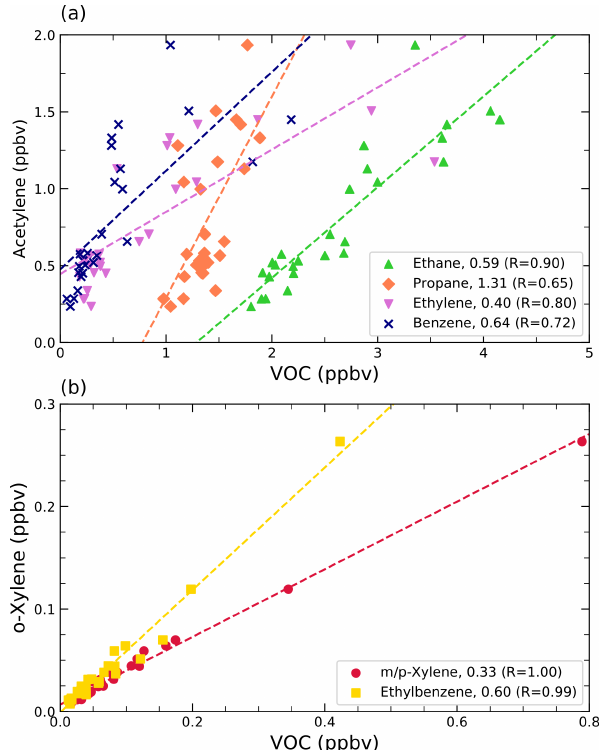
Figure 7. (a) Scatterplot of acetylene with ethane (green upward triangles), propane (orange diamonds), ethylene (purple downward triangles), and benzene (navy × ’s) for all WAS canisters during ARIAs. (b) Regression plots of o -xylene with m / p -xylene (red cir- cles) and ethylbenzene (yellow squares). The dashed lines show the results of a linear least squares regression line for all data